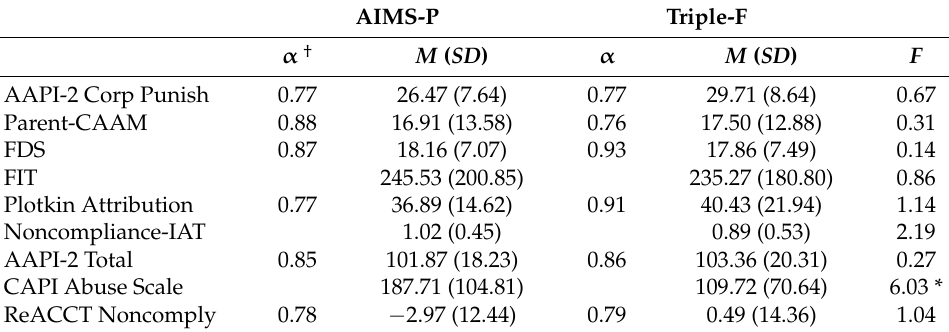
Table 2. Sample Descriptive Statistics and Group Differences.